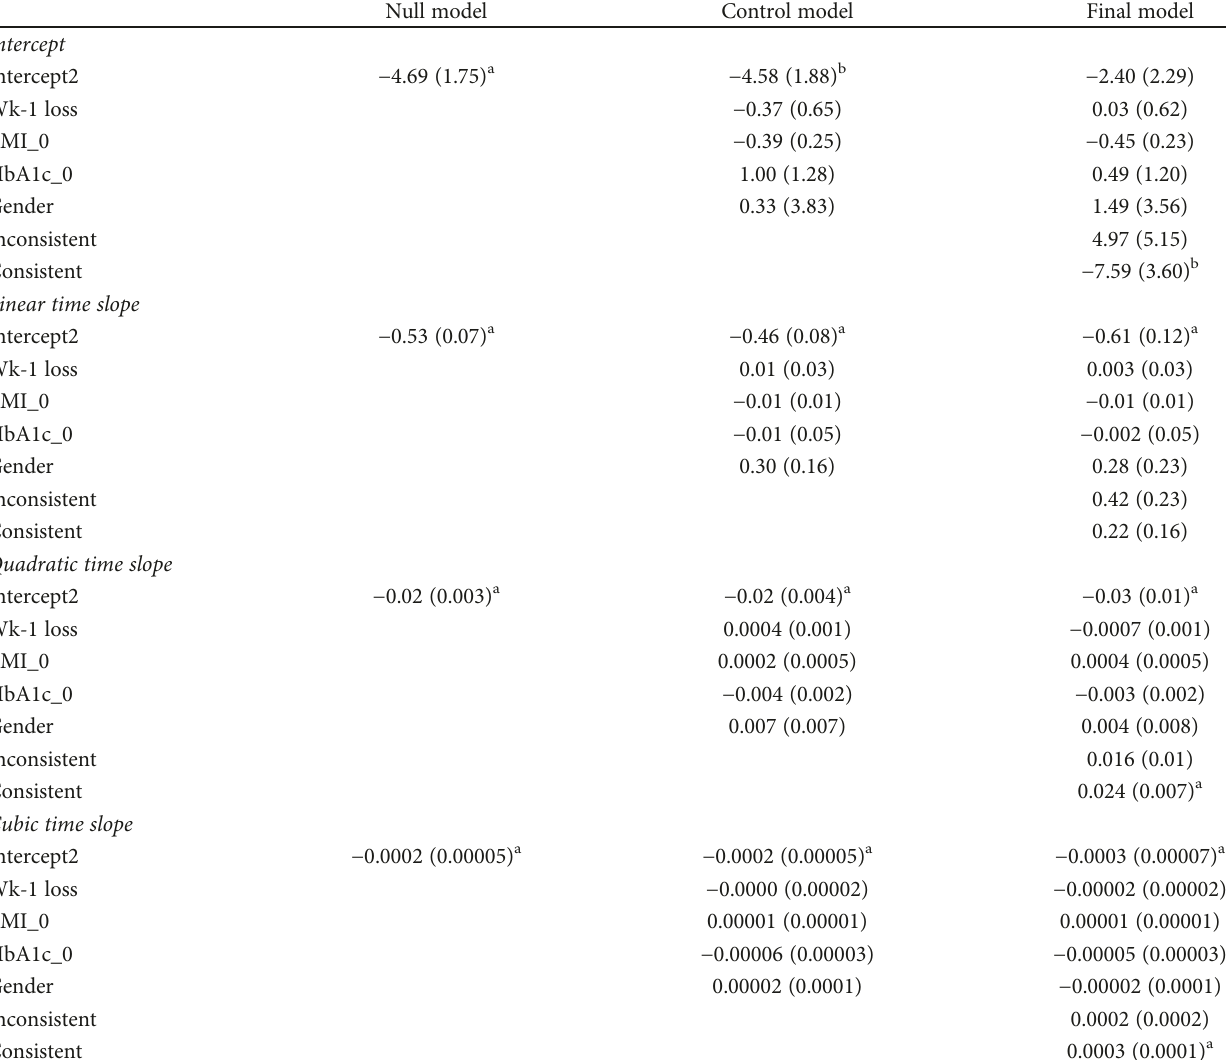
Table 2: Comparison of model parameters (standard error) across the null, control, and fi nal models on fi nal weight outcome in